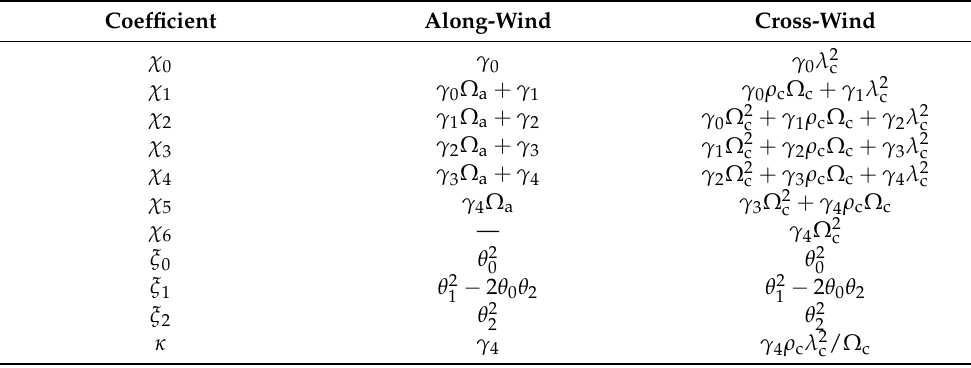
Table 5. Dimensionless filter coefficients for the controlled wind-induced